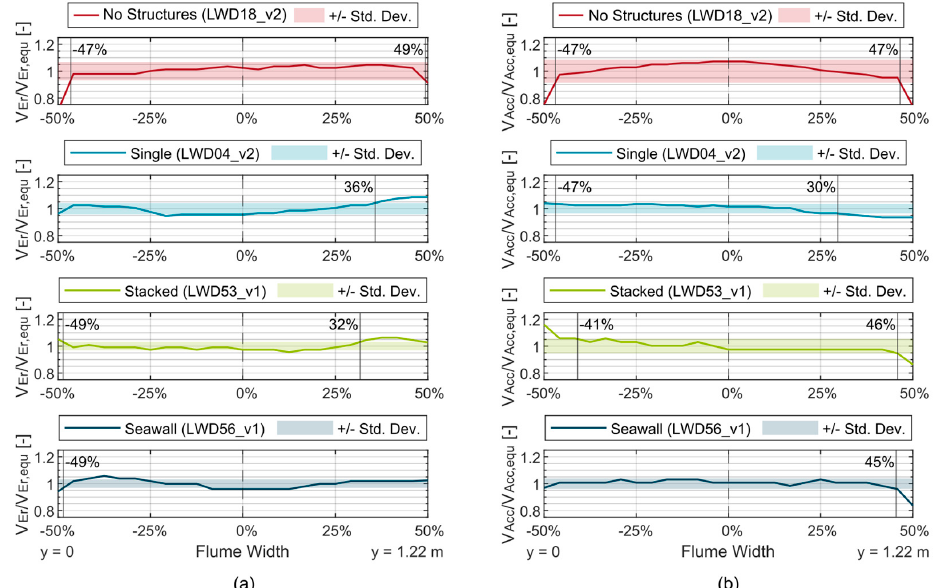
Figure 8. Deviation from a uniform distribution of ( a ) eroded volume (V Er /V Er,equ ), and ( b ) accreted volume (V Acc /V Acc,equ ) over the width of the flume for all tests under large wave conditions (T p = 2.51 s, H s = 0.20 m).